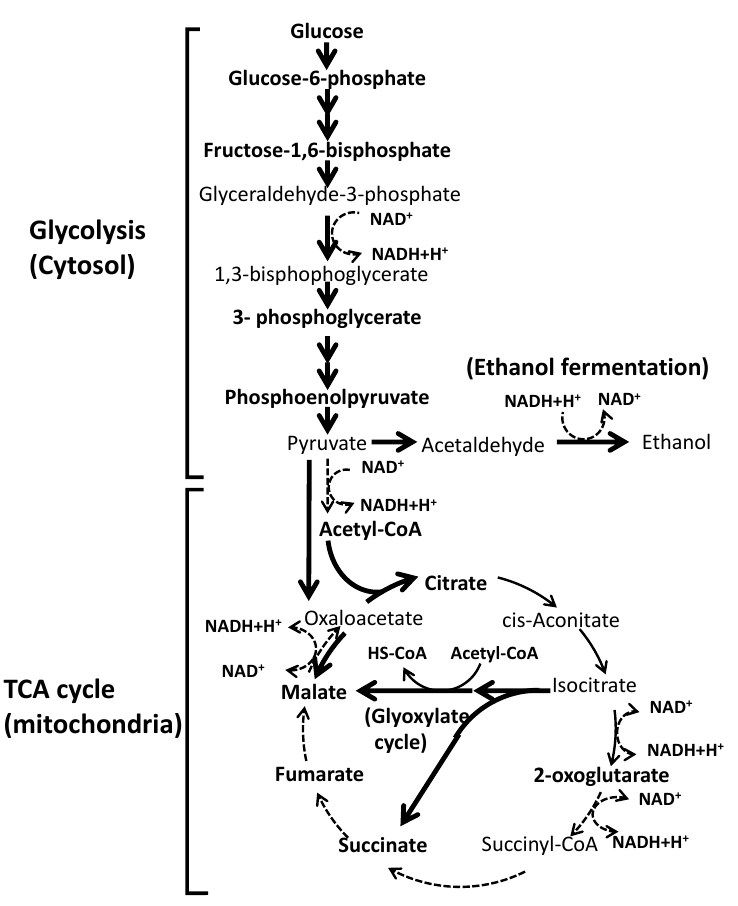
Figure 5. The deduced restricted reaction steps of glycolysis and the TCA cycle based on the present study. The analyzed metabolites are shown in bold letters. The thick solid arrows indicate reaction steps that were comparable between strains KA31a and a924E1. The thin solid arrows indicate reaction steps that were restricted in strain a924E1. The dotted arrows indicate the reaction steps that were almost completely inhibited in strain a924E1.